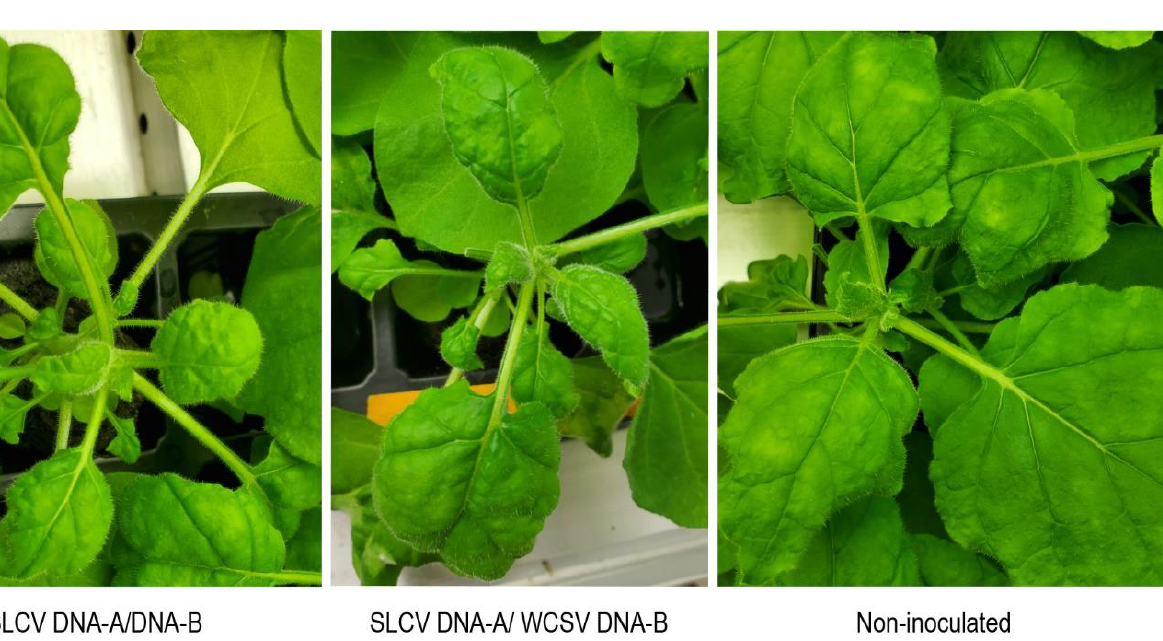
Figure 4. Nicotiana benthamiana plants infected with SLCV DNA-A/DNA-B; SLCV DNA-A/WCSV DNA-B showing leaf curling symptoms. As a control, an image of a noninoculated N. benthamiana plant.